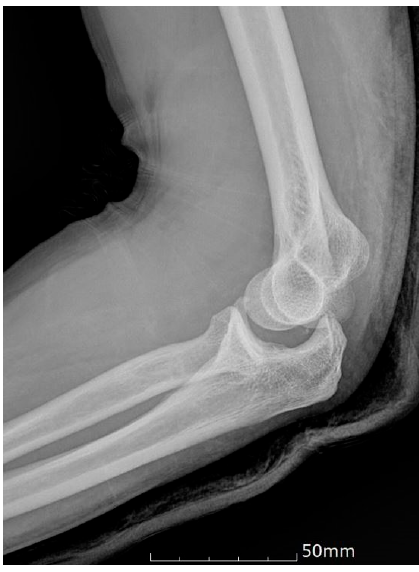
Figure 2. Post-reduction lateral radiograph reveals incongruence at the ulno-humeral articulation.